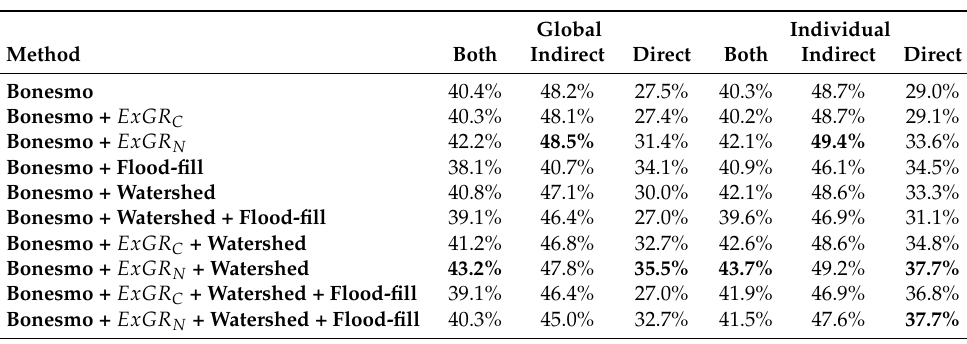
Table 2. Training results for the image segmentation. All the results shown are the percentage frequency-weighted intersection over union. The first three columns (“global”) show the results for each method, when they are trained independently of the illumination. Indirect and direct show the results for the images of the two illuminations, respectively. Both show the combination of the results from the two illuminations. The last three columns (“individual”) show the results for each method, where the two illuminations are treated separately. The highest frequency weighted intersection over union is bolded in each